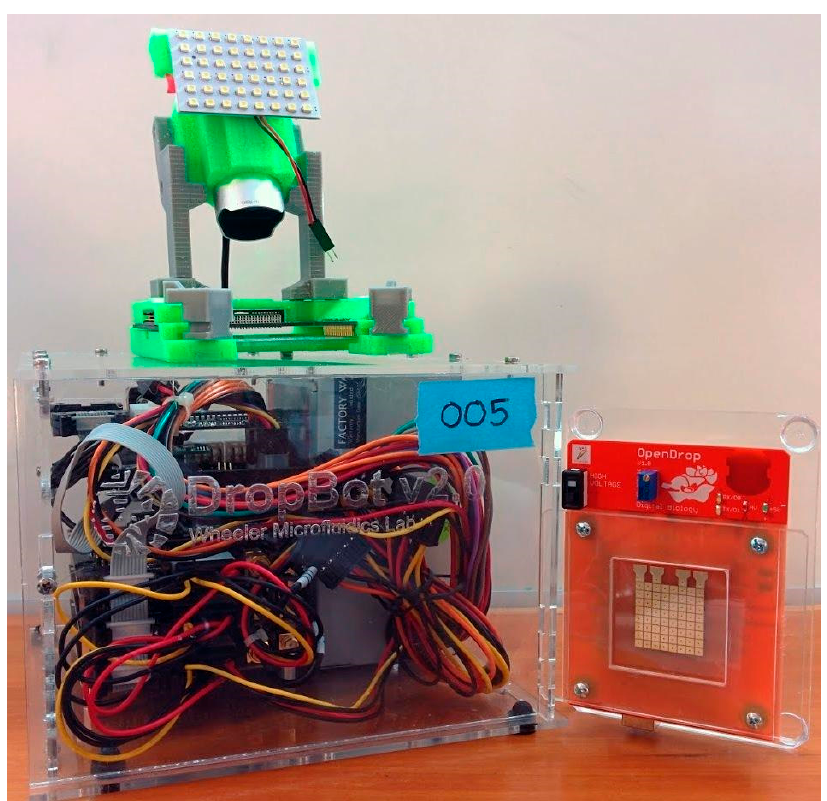
Figure 14 . Dropbot ( left ) and O PEN D ROP ( right ) picture by Ryan Fobel. Figure 14. Dropbot ( left ) and O PEN D ROP ( right ) picture by Ryan Fobel.